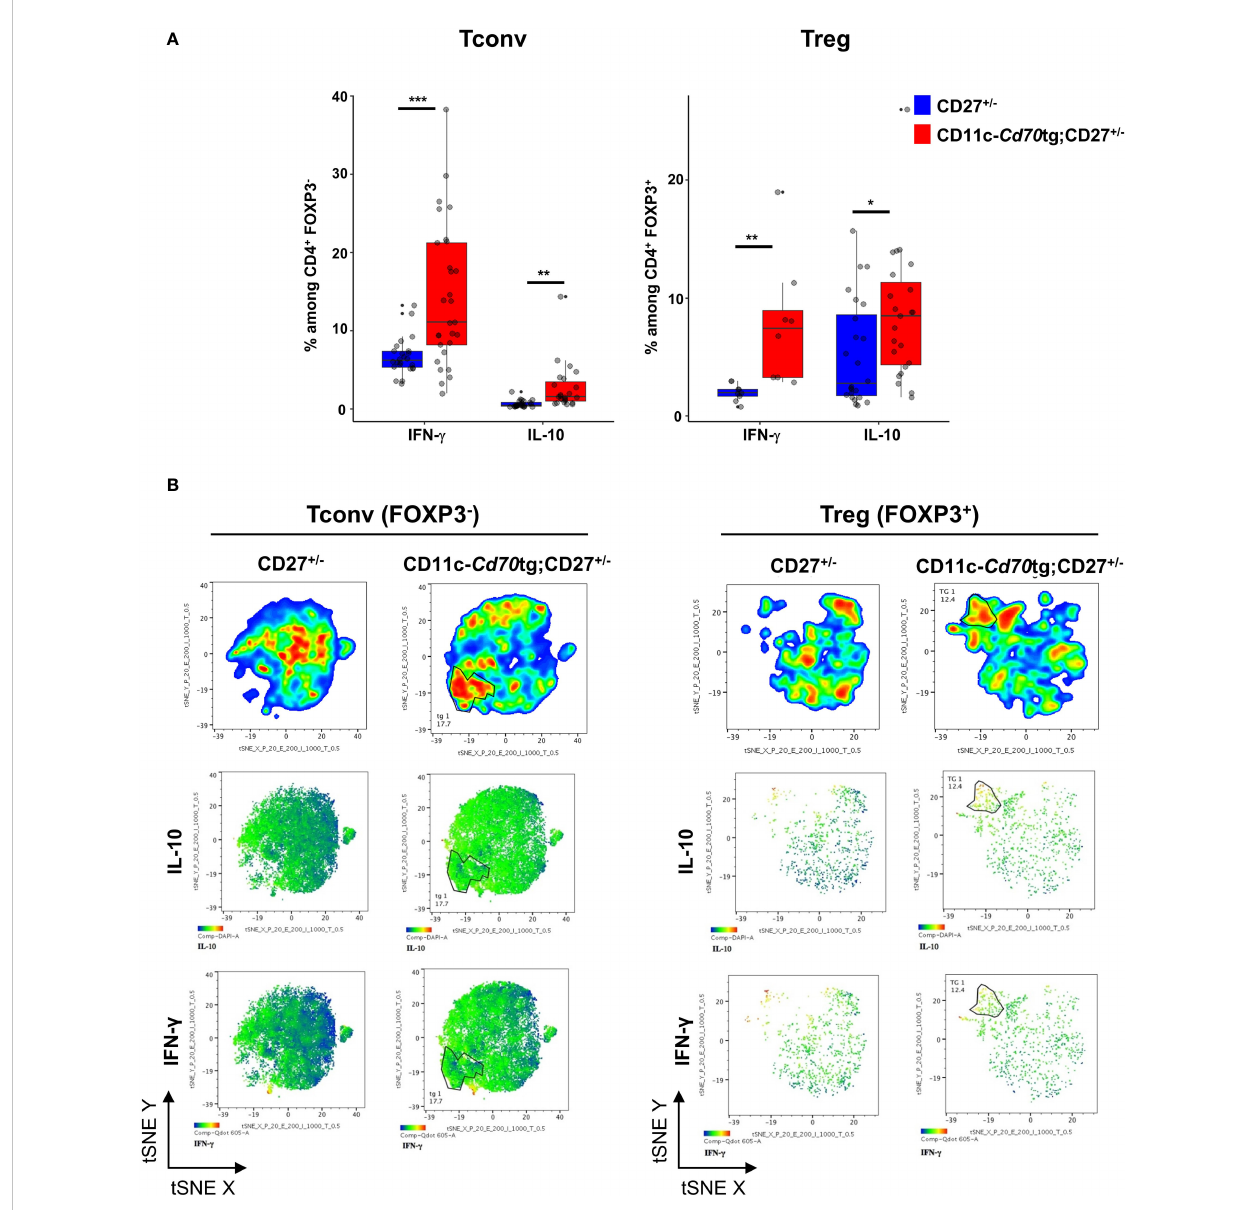
FIGURE 3 Transgenic expression of CD70 on dendritic cells induces the differentiation of type 1 effectors. (A) Proportion of Tregs (left) and Tconvs (right) expressing IFN- g or IL-10 after short stimulation in vitro with phorbol myristate acetate (PMA)-ionomycin in the presence of brefeldin A. Data are from 3 independent experiments with 3-8 mice per group. Bars represent median ± SD. Unpaired t-test was used to determine statistical differences followed by FDR correction for multiple comparisons (*p < 0.05; **p < 0.01; ***p < 0.001; ns, not signi fi cant). (B) Merged (n = 8) tSNE plot after dimensionality reduction and unsupervised clustering of fl ow cytometry data from Tconvs and Tregs. The tSNE was built on the 3 markers and both